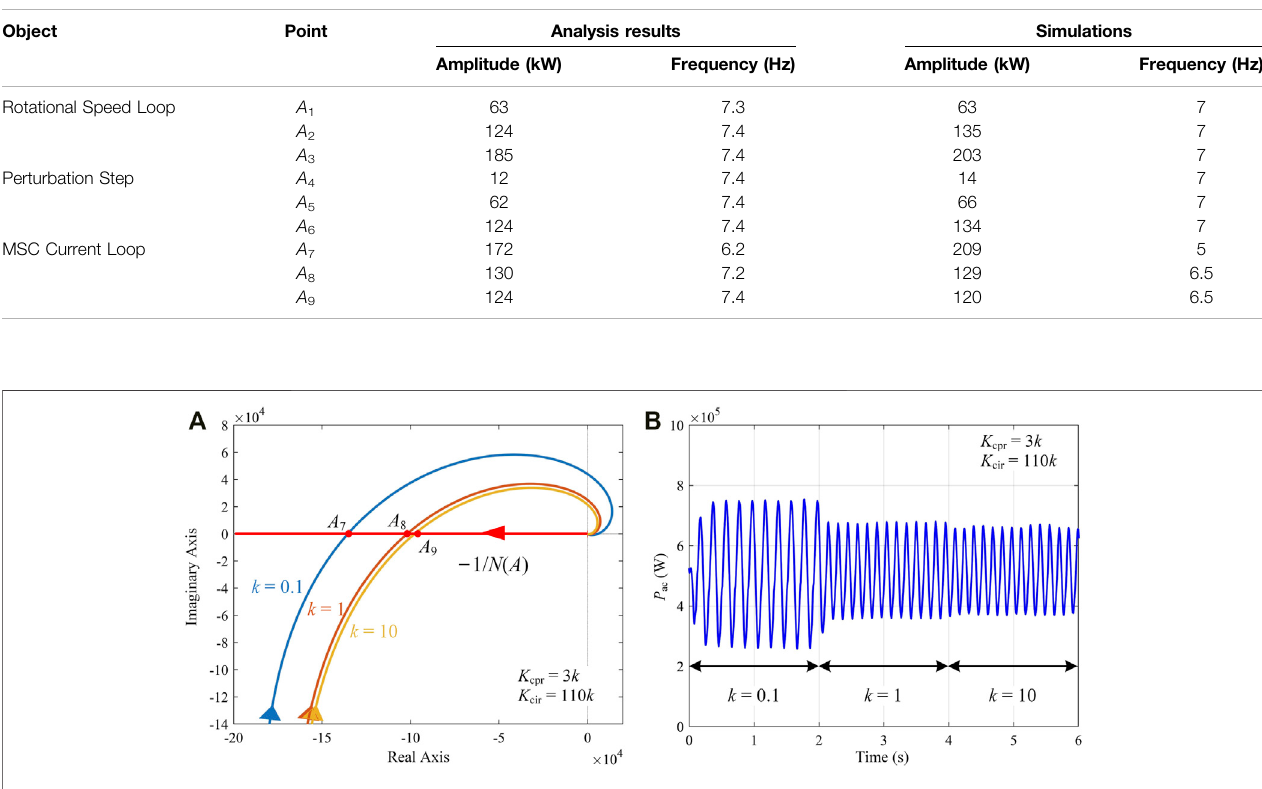
Frontiers in Energy Research |